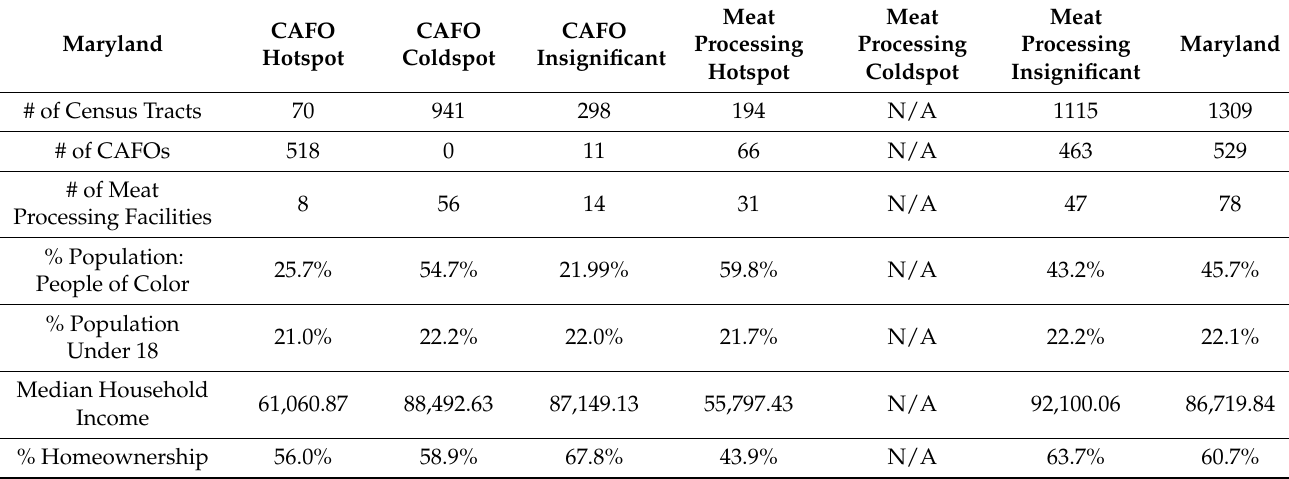
Figure 3. Optimized Hotspot Analysis for Chicken CAFOs on the Eastern Shore of Maryland. Table 2. CAFO and Meat Processing Hot/Coldspots vs. MD